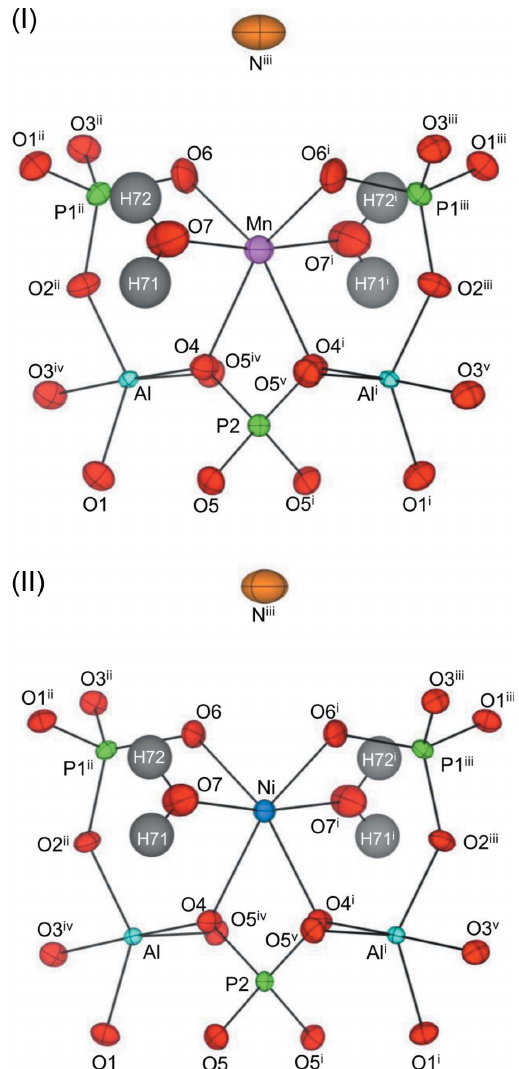
Figure 2 Positions of the M O 6 [ M = Mn (I) and Ni (II)] octahedra in the twelve- membered-ring channel of the aluminophosphate framework. Displace- ment ellipsoids are presented at the 80% probability level. [Symmetry codes: (i) (cid:4) x , y , (cid:4) z + 1 (cid:4) y + 1, z (cid:4)